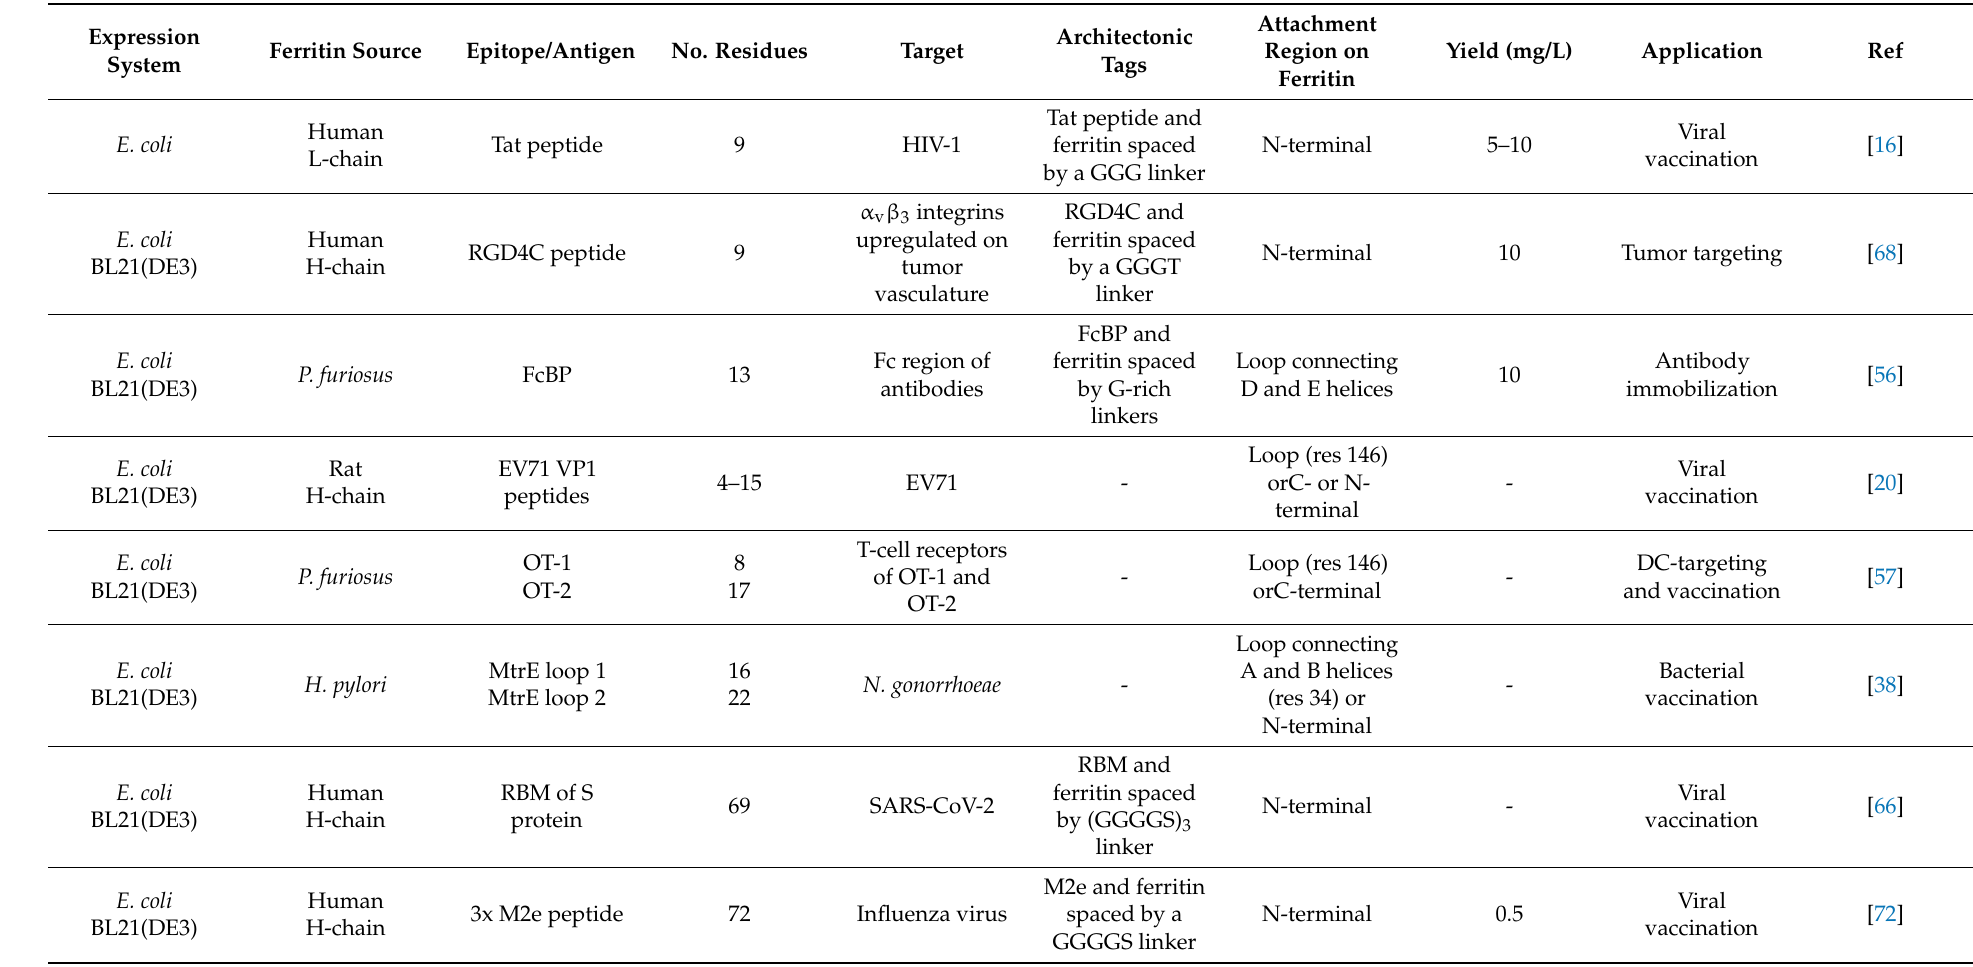
Table 2. Surface functionalization of ferritin nanoparticles by genetic fusion for antigen-display